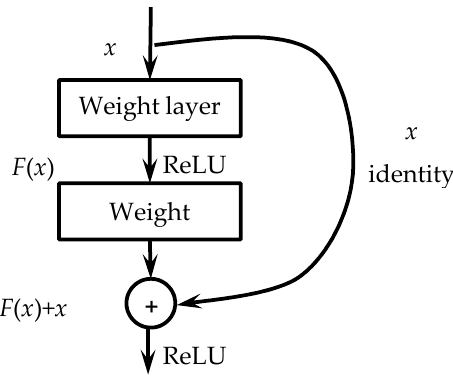
Figure 8. Residual block.